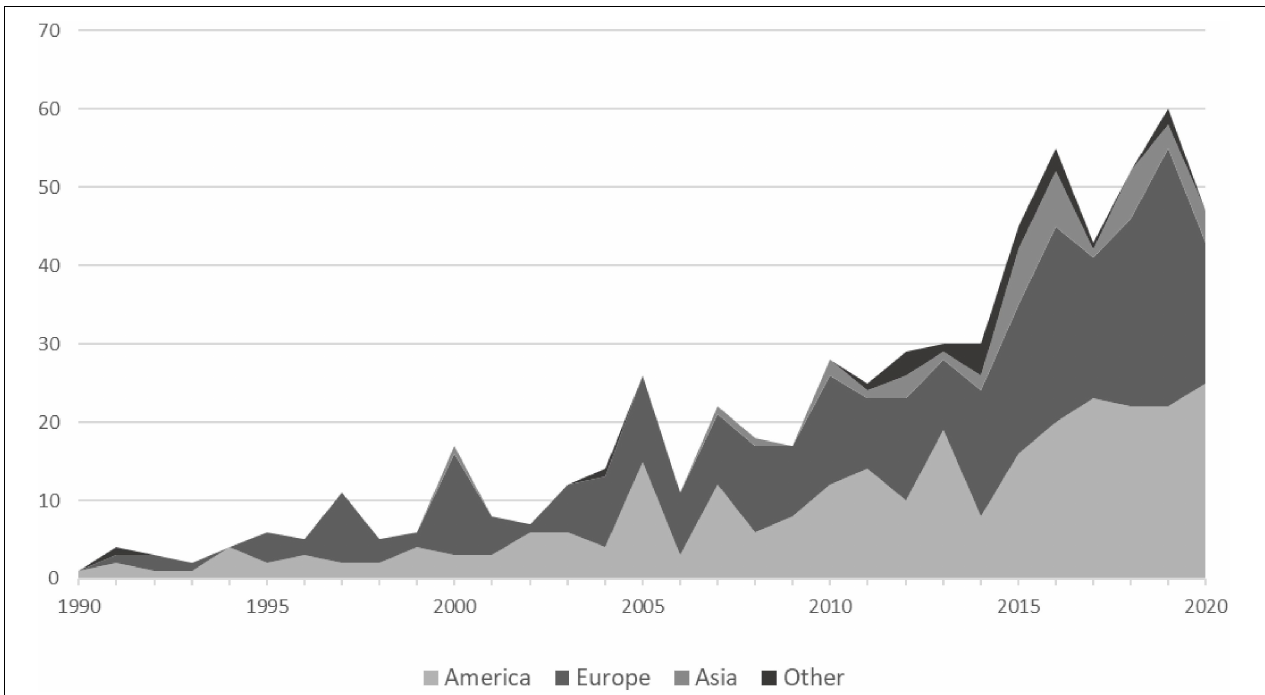
FIGURE 3 | Number of dyadic coping (DC) publications between 1990 and 2020 grouped by continents. The category “Other” includes studies from Africa and Oceania; “America” includes studies from North and South